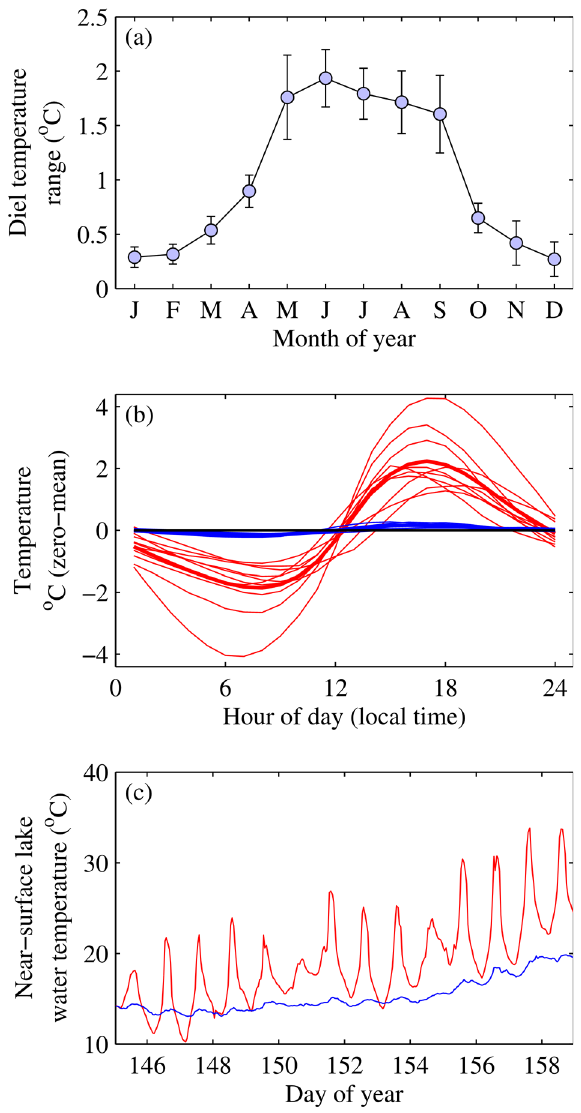
Fig 1. Temporal variability in near-surface lake water temperature. (a) Seasonal variability in the diel temperature range for 96 Northern Hemisphere lakes with 95% confidence intervals (note that not all lakes had data for the whole year). (b) Individually normalized (zero-mean) summer average diel cycle for the lakes that had the highest (red) and lowest (blue) 10% of diel temperature ranges measured. The bold lines represent the mean diel cycle for the 10% considered and the horizontal black line indicates zero. For clarity, we excluded Jekl Bog, which had the highest diel cycle, from this figure. (c) Example of hourly-resolution near-surface lake water temperature variation at Jekl Bog (surface area 2.5 x 10 3 m 2 , red), and Sparkling Lake (surface area 6.2 x 10 5 m 2 , blue), both situated in Wisconsin,